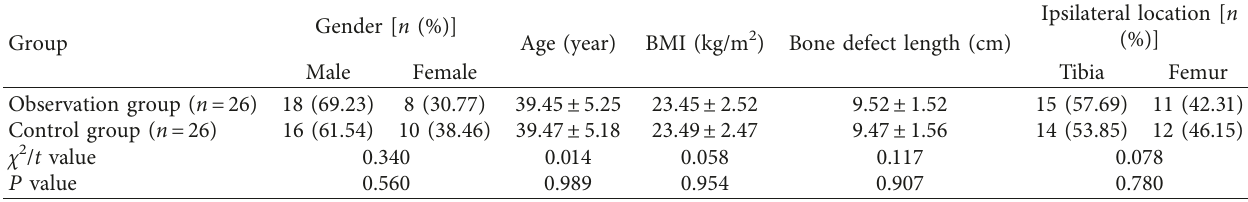
Table 1: Comparison of general data between the two